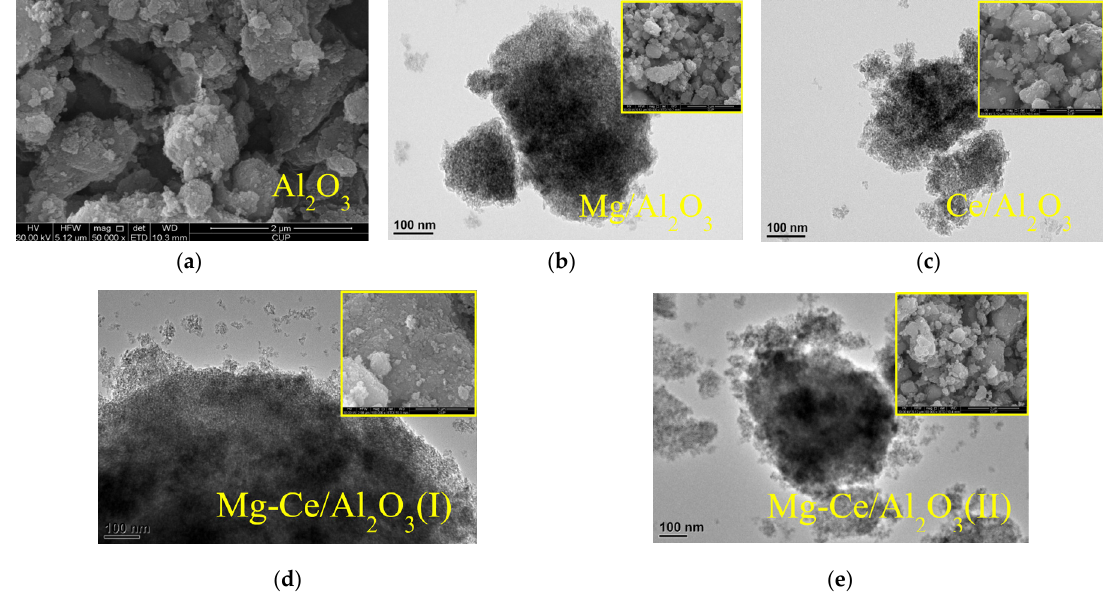
Figure 2. Scanning electron microscope (SEM) image of Al 2 O 3 substrate ( a ) and transmission electron microscope micrographs of loaded Al 2 O 3 with inset SEM images: ( b ) Mg/Al 2 O 3 ; ( c ) Ce/Al 2 O 3 ; ( d ) Mg ‐ Ce/Al 2 O 3 (I); ( e ) Mg ‐ Ce/Al 2 O 3 (II).